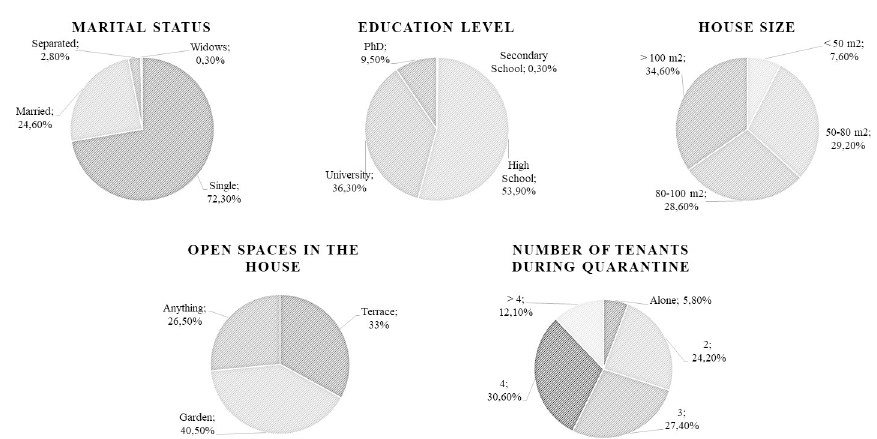
Fig 1. This is the demographic information on the sample and housing characteristics during